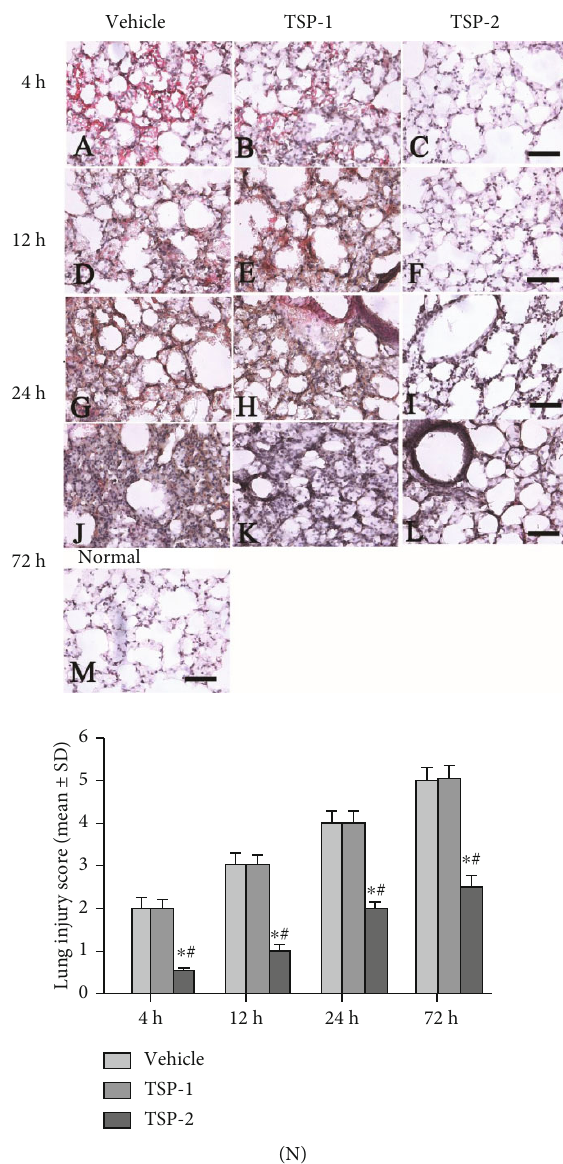
Figure 7: E ff ect of TSP-2 overexpression on pulmonary morphology in the ARDS mouse model. Lung tissue sections from mice treated with LPS for 4, 12, 24, and 72h and overexpressing either empty vector (vehicle group), TSP-1 (TSP-1 group), or TSP-2 (TSP-2 group) were analyzed for pulmonary morphology using H&E staining (a – l). (m) Normal control: the normal morphology of blood vessels, bronchi, and interstitium. Scale bar = 100 μ m . (n) Bar graph of lung injury scores from three di ff erent groups, assessed by two independent pathologists blinded to the experimental conditions. Scoring was based on the following: 0 = no injury; 1 = edema/ fi brin, hemorrhage (subpleural); 2 = edema/ fi brin, hemorrhage (interlobular); 3 = edema/ fi brin, hemorrhage (alveolar); 4 = congestion of alveolar septa; 5 = hyaline membrane changes of alveolar septa. The lung injury score of each group is shown as mean ± SD . P value of < 0.05 represents signi fi cant di ff erence. a P < 0 : 05 compared with normal control; b P < 0 : 05 compared with the vehicle group; c P < 0 : 05 compared with the TSP-1 transfected group ( n = 5 per